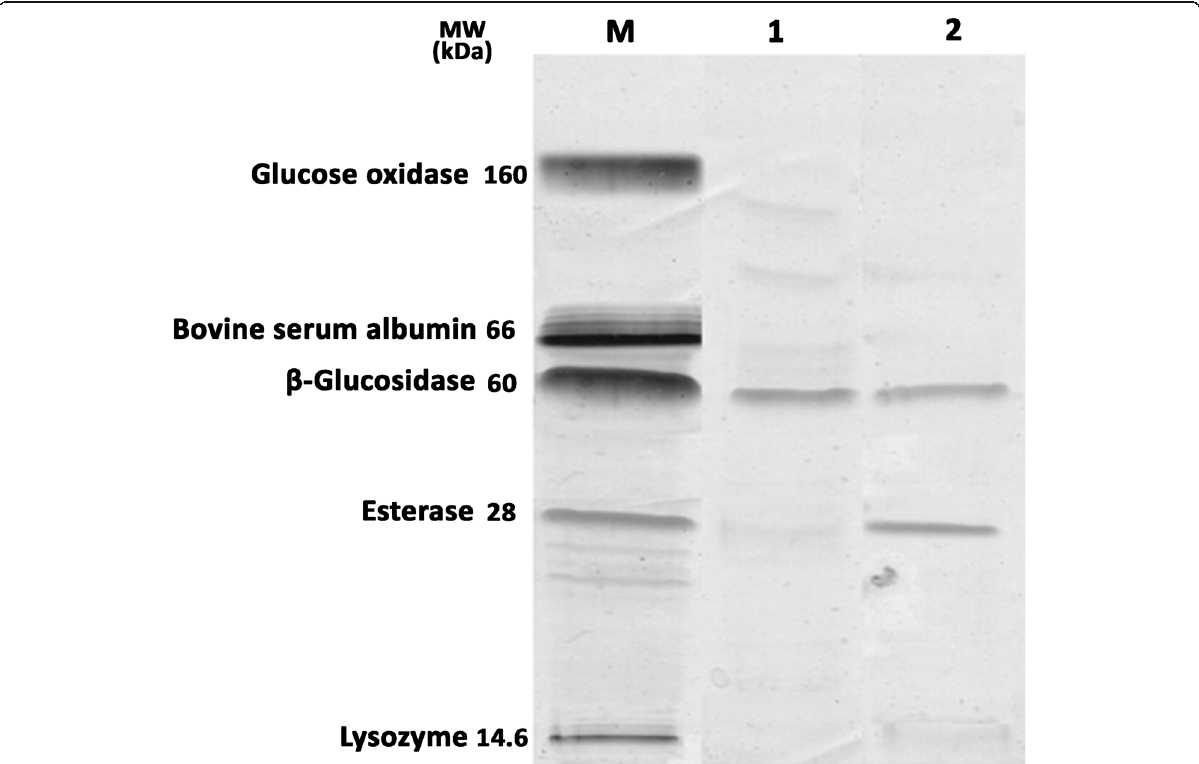
Fig. 3 Electrophoretic profile (SDS-PAGE) of proteins extracts of L. plantarum FSO1 (lane 1) and C. pelliculosa L18 (lane 2) cultures obtained in modified MRS broth (containing OLP 1% as sole carbon source) after 7 days of culture at 30 °C (M: Molecular weight (kDa) of